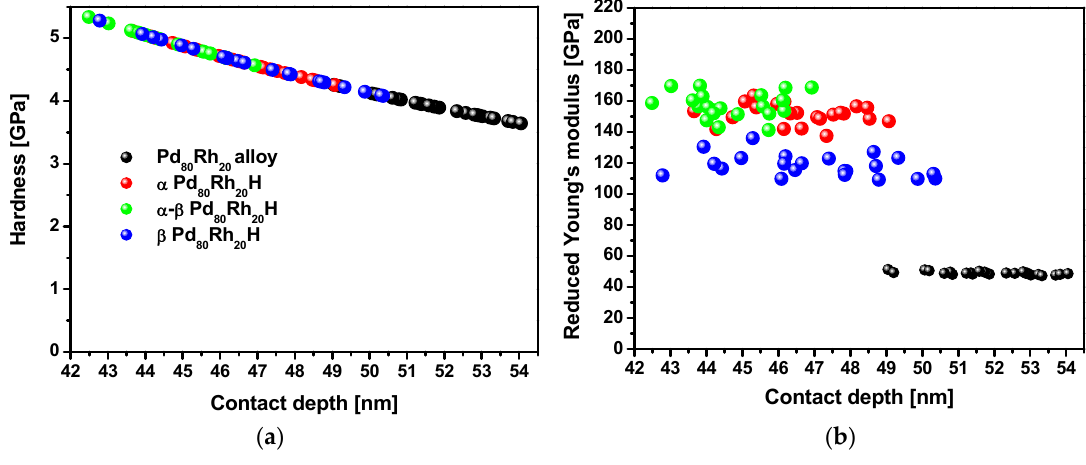
Figure 9. Distribution of nanomechanical parameters for the Pd 80 Rh 20 alloy, α Pd 80 Rh 20 H, α - β Pd 80 Rh 20 H, and Pd 80 Rh 20 H as a function of the contact depth: ( a ) nanohardness; ( b ) reduced Young’s modulus. Symbols in ( a ) and ( b ) are the same.